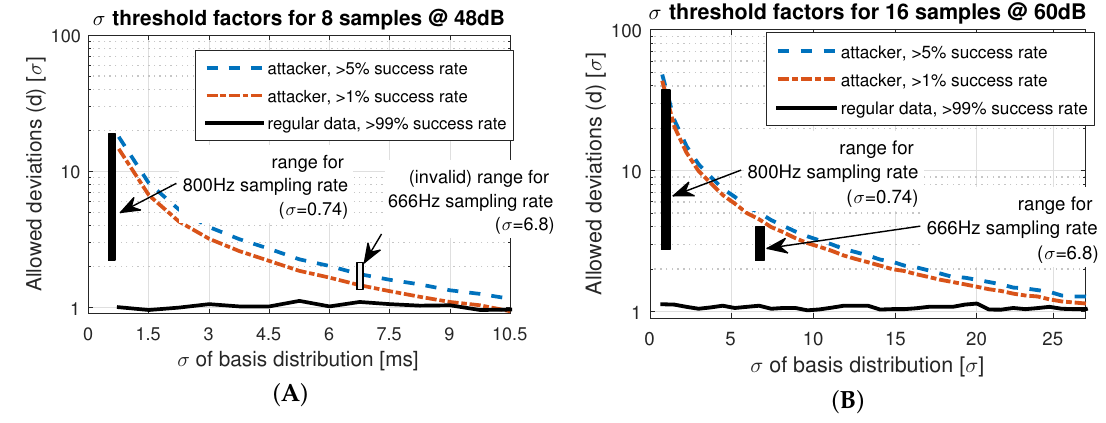
Figure 15. Impact of increased basis variance (e.g., more noise) on the allowed thresholds to limit false positives and false negatives, for ( A ) 8 samples at 48 dB, and ( B ) 16 samples at 60